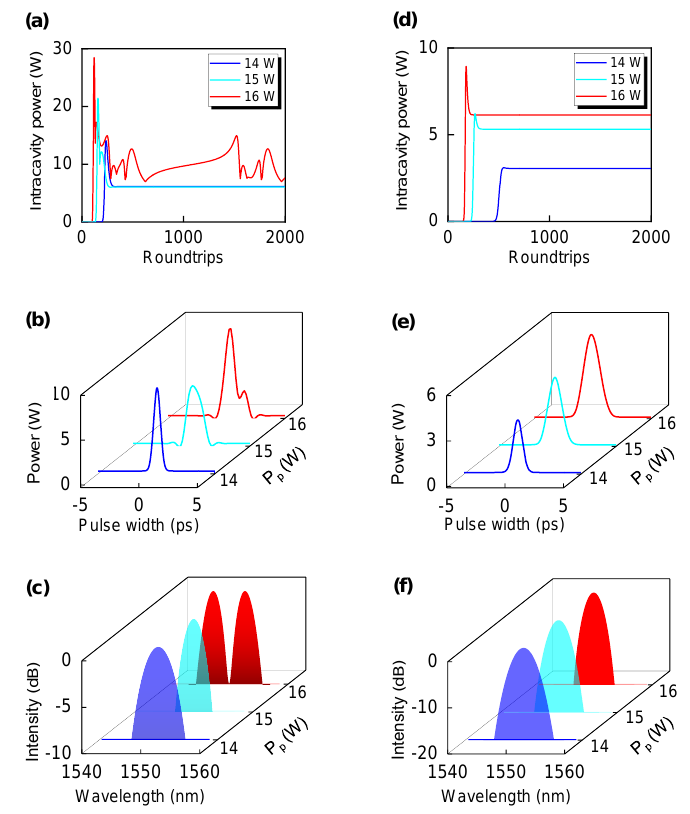
Figure 2. The evolution of the intracavity power of the signal field A ( a ) without ( γ 1 = γ 2 = γ 12 = γ 21 = 0) and ( d ) with ( γ 1 = γ 12 = 0.66 W − 1 m − 1 , γ 2 = γ 21 = 1.32 W − 1 m − 1 ) third-order nonlinearity for the peak power of pump P p increases from 14 W to 16 W. Temporal profile and corresponding spectrum [( b , c )] without and [( e , f )] with third-order nonlinearity for the peak power of pump P p increases from 14 W to 16